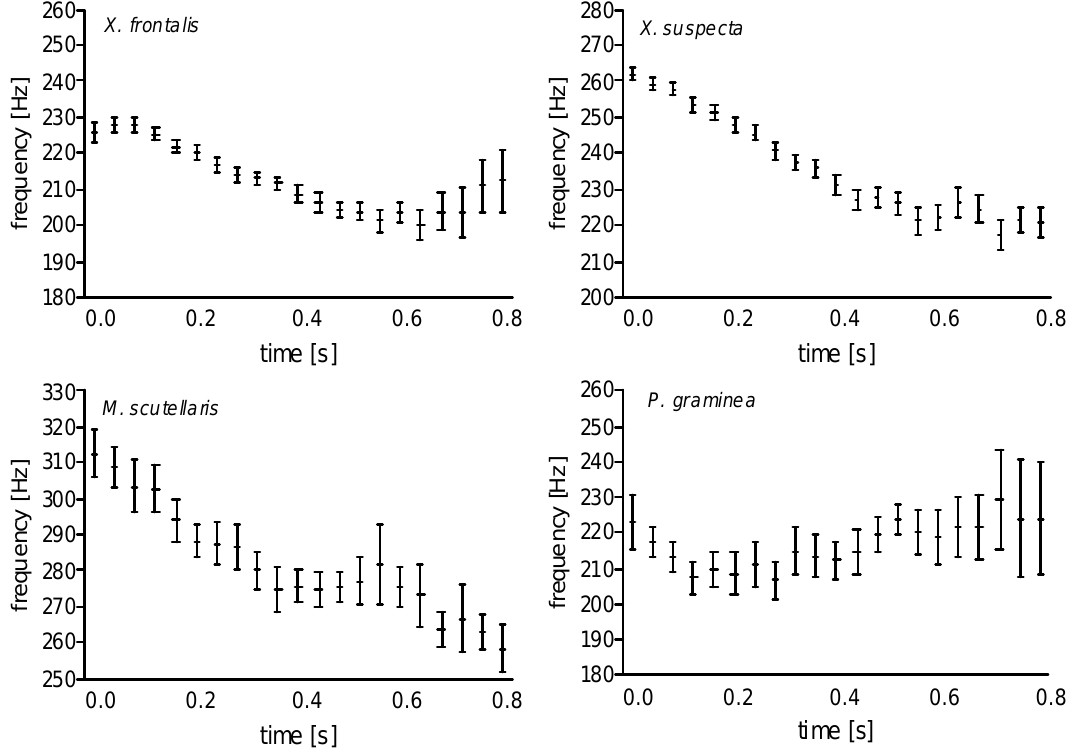
F IG . 4. Buzzing pattern of Xylocopa frontalis (n = 103), X. suspecta (n = 141), Melipona scutellaris (n = 12) and Pseudaugochlora graminea (n = 20); average pattern plotted in 0.04 s steps (mean ±